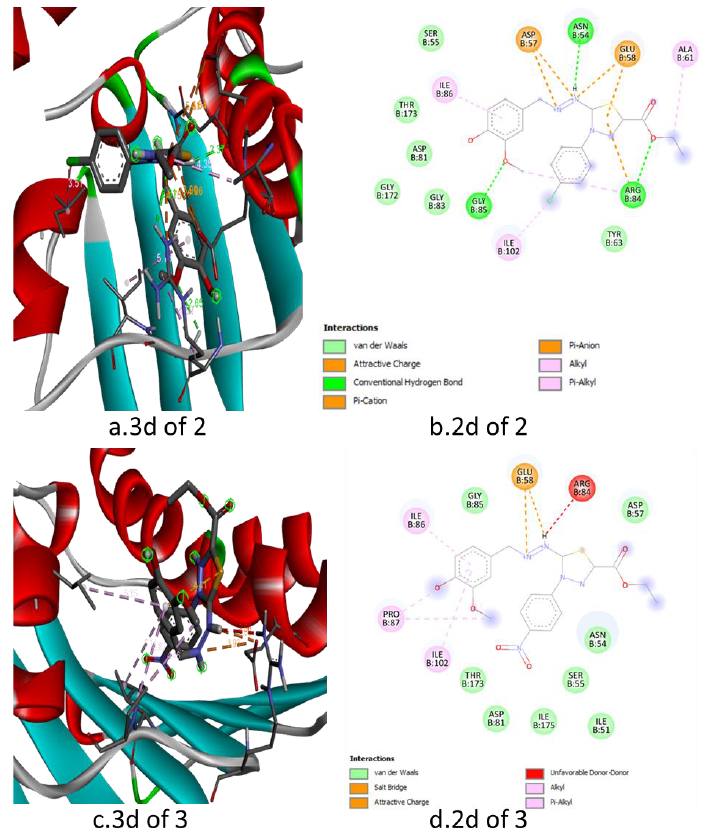
Figure 7. Interaction of the docked compounds 2 and 3 with bacterial DNA gyrase B.